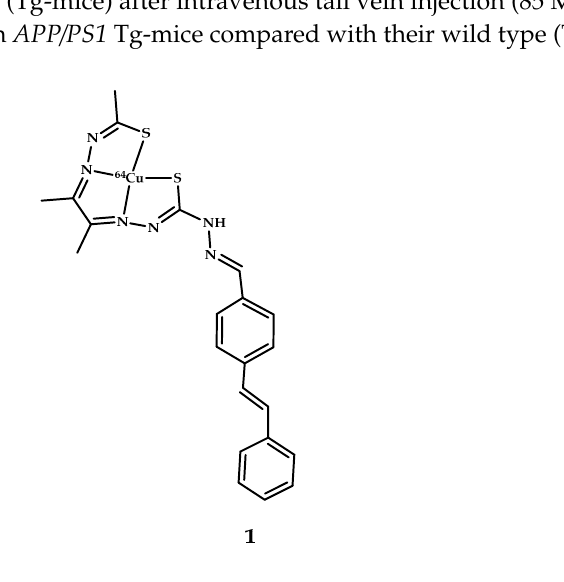
Figure 2. 64 Cu(II)-ATSM derivative 1 conjugated with stilbene functional group, designed for A β fibrils